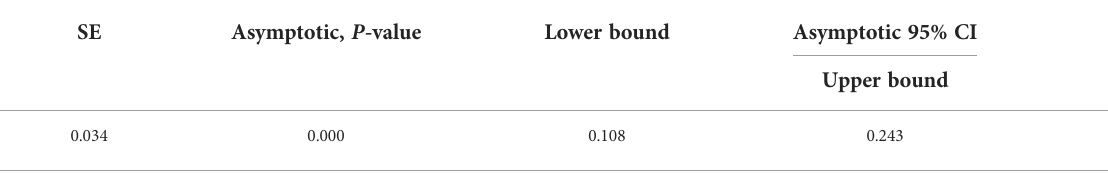
TABLE 4 Area under the receiver operating characteristic